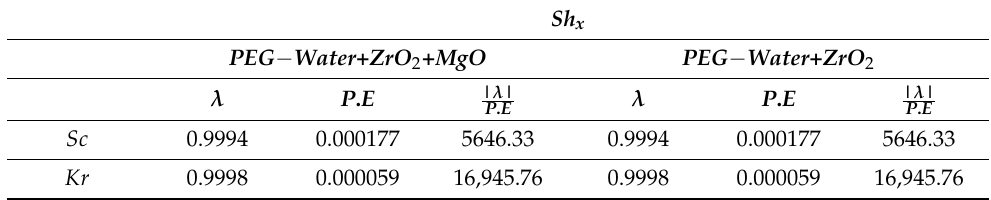
Table 5. Some factors’ link with mass transfer